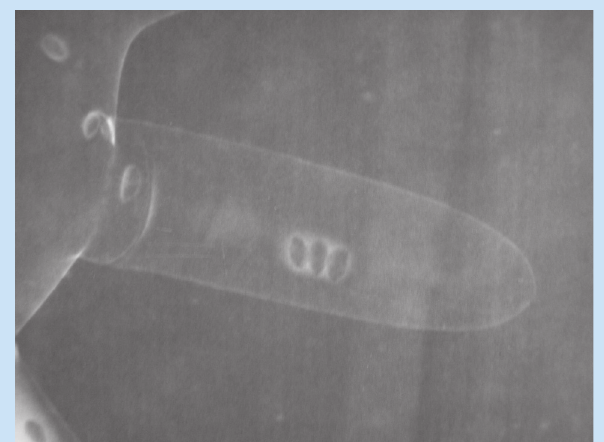
Fig. 1b. Multiple linseed shadows during simulation in latex glove.